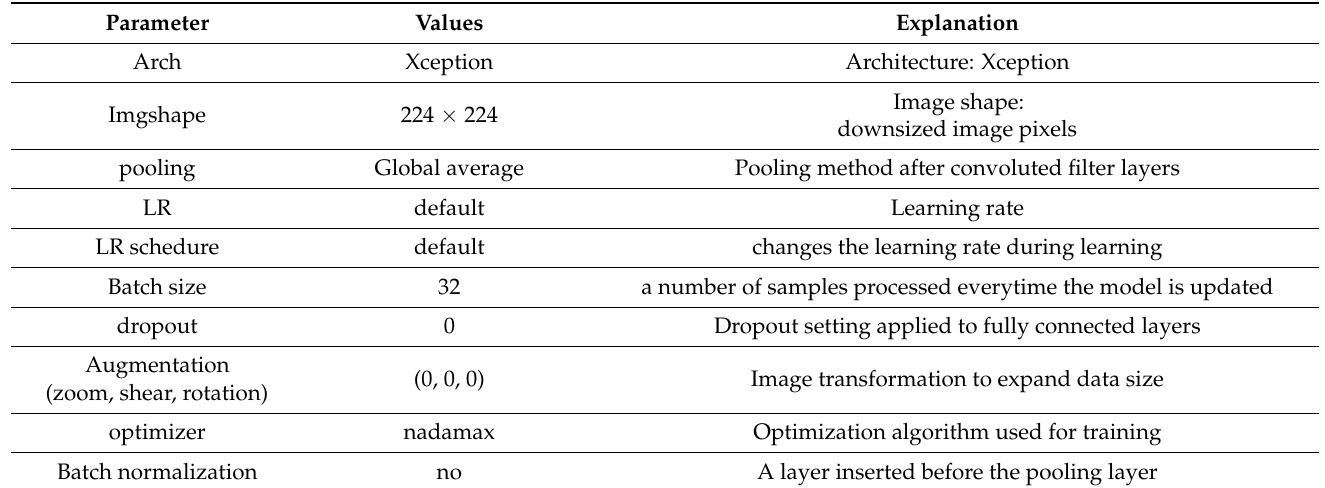
Table 1. Hyperparameters during model training.